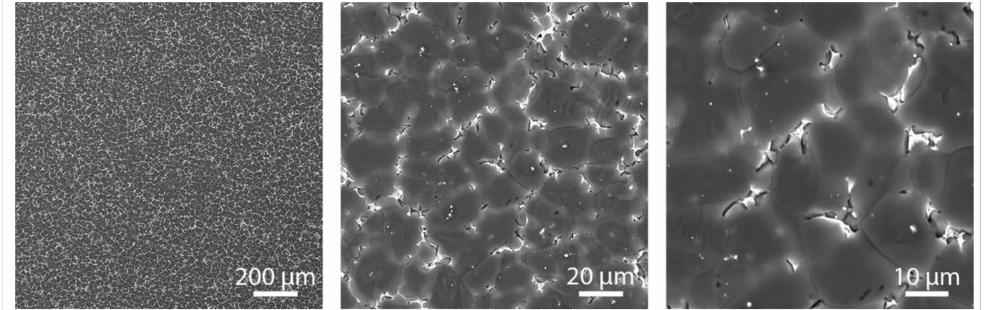
Figure 2. Microstructure of the reference as-cast WE43 alloy at different